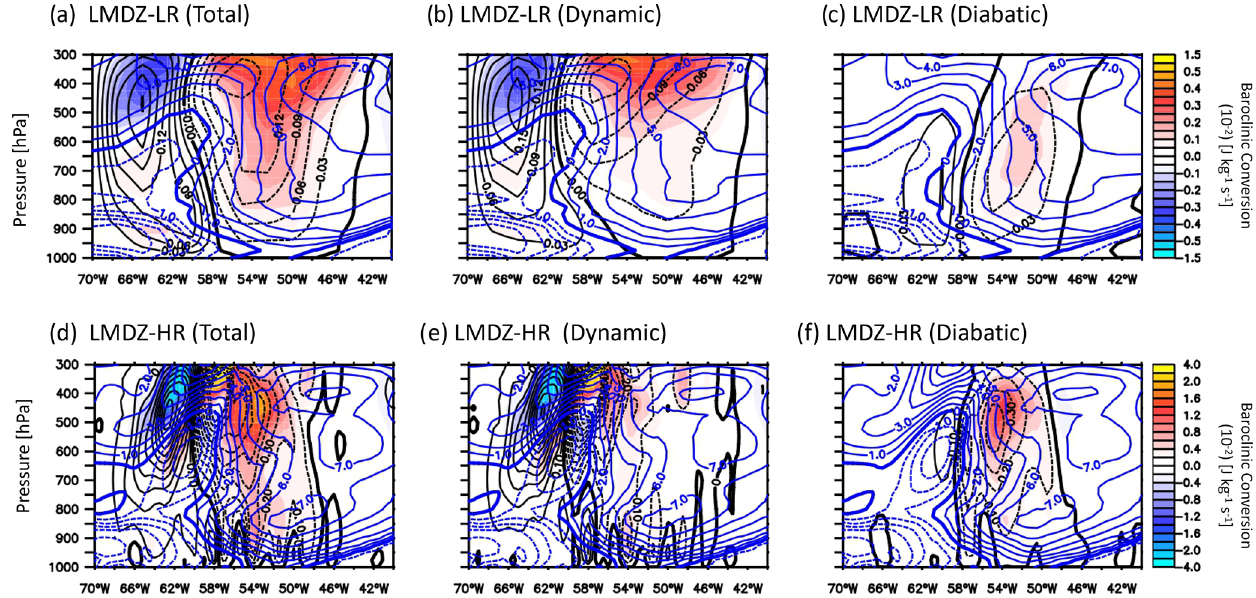
Figure 6. A vertical cross section averaged across the northern precursor in the LMDZ hindcasts at 18:00UTC 29 September 2016 ( T + 18h). The baroclinic conversion (shaded), potential temperature anomaly (blue contours), and inverted ω (black contours) for (a, d) total baroclinic conversion, (b, e) the baroclinic conversion due to dynamic processes only, and (c, f) the baroclinic conversion from diabatic processes. (a–c) LMDZ-LR and (d–f) LMDZ-HR. Note that the colour scales and contours are different between the LR and HR